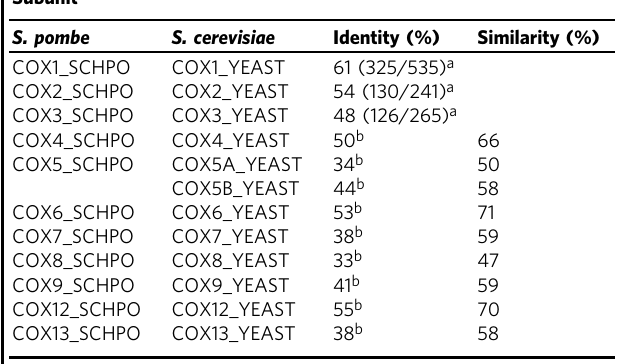
Table 1 Annotated S. pombe CIV